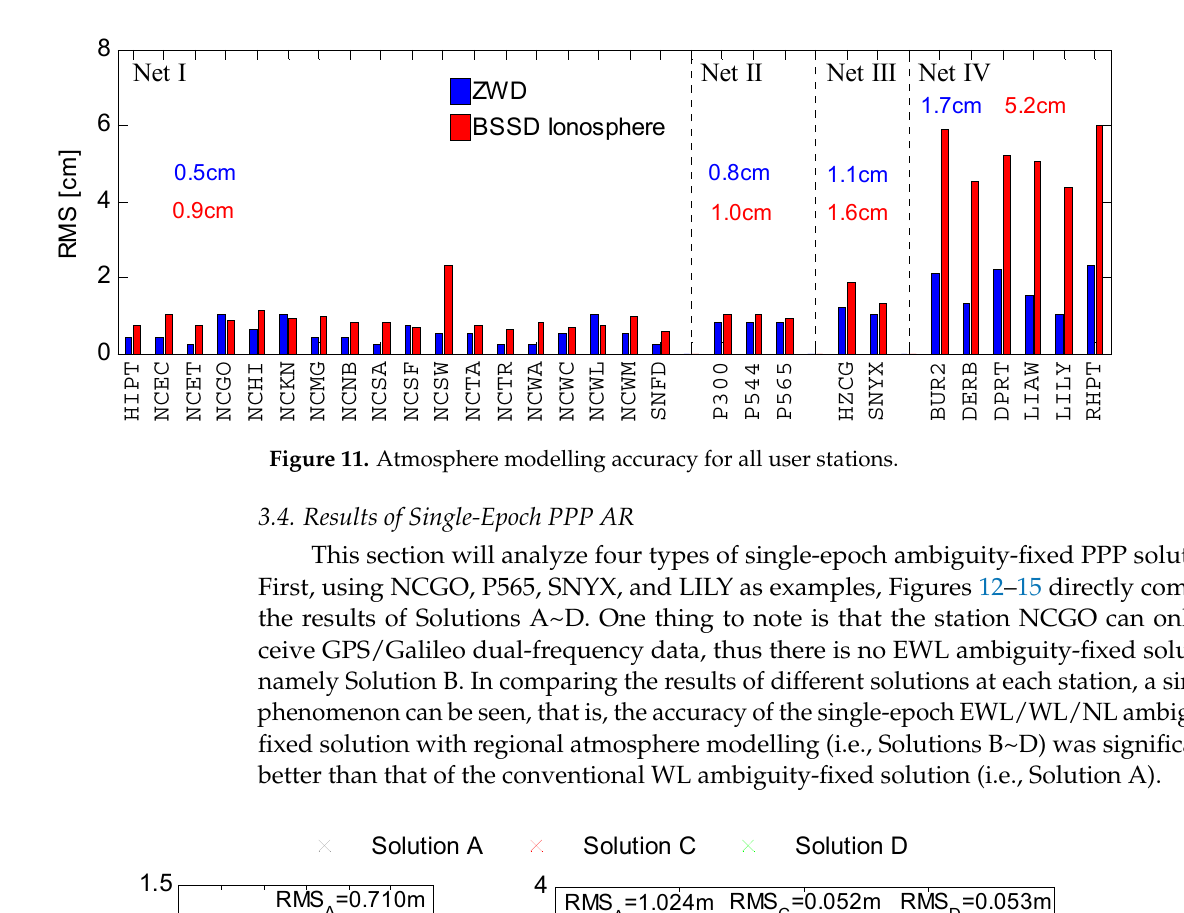
14 of 24 Figure 9. BSSD ionosphere interpolation errors of GPS/Galileo/BDS-2/BDS-3 at station SNYX. Figure 10. BSSD ionosphere interpolation errors of GPS/Galileo/BDS-2/BDS-3 at station LILY. Figure 11 further shows the atmosphere modelling results for all user stations. Over-